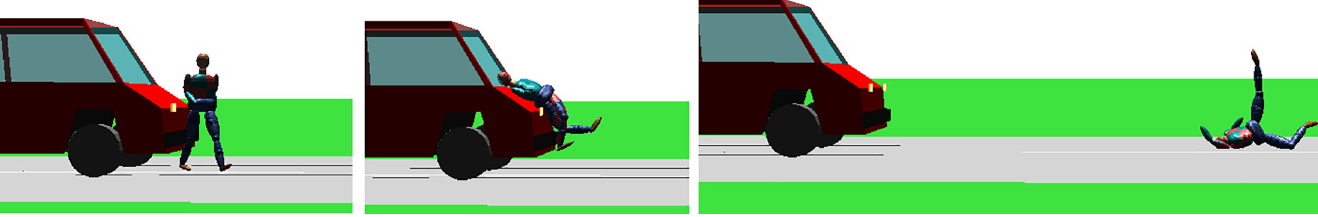
Fig 4. Posture of the pedestrian after collision. (A) t = 0.020 s. (B) t = 0.100 s. (C) t = 1.119